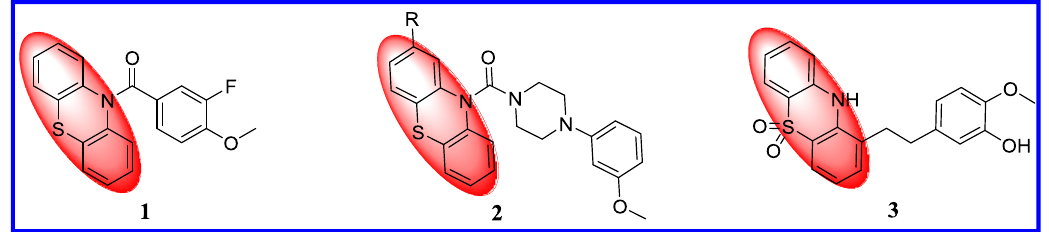
Figure 1. Phenothiazine derivatives as novel anticancer agents.